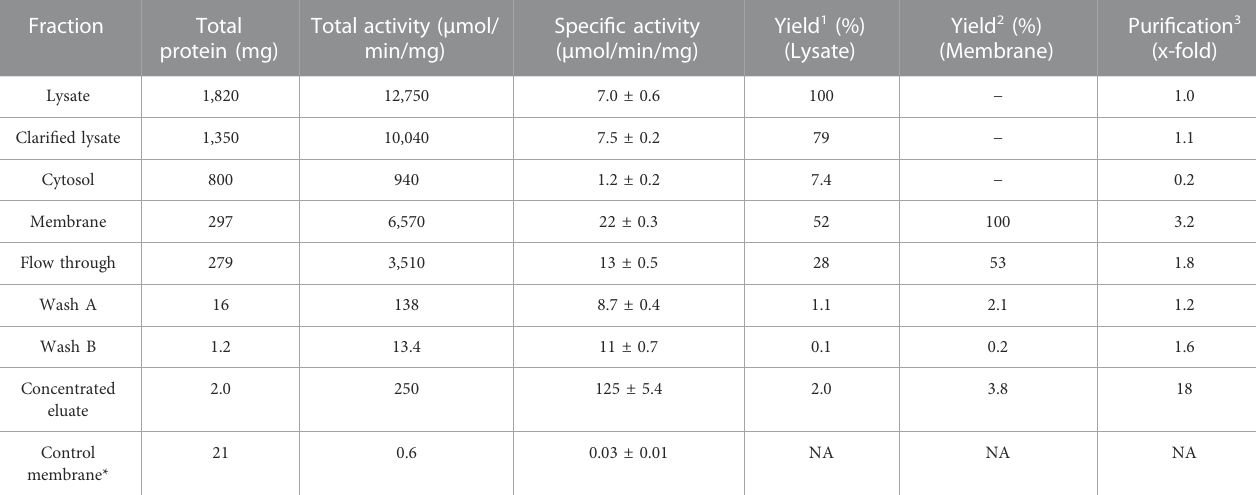
TABLE 1 Puri fi cation table of